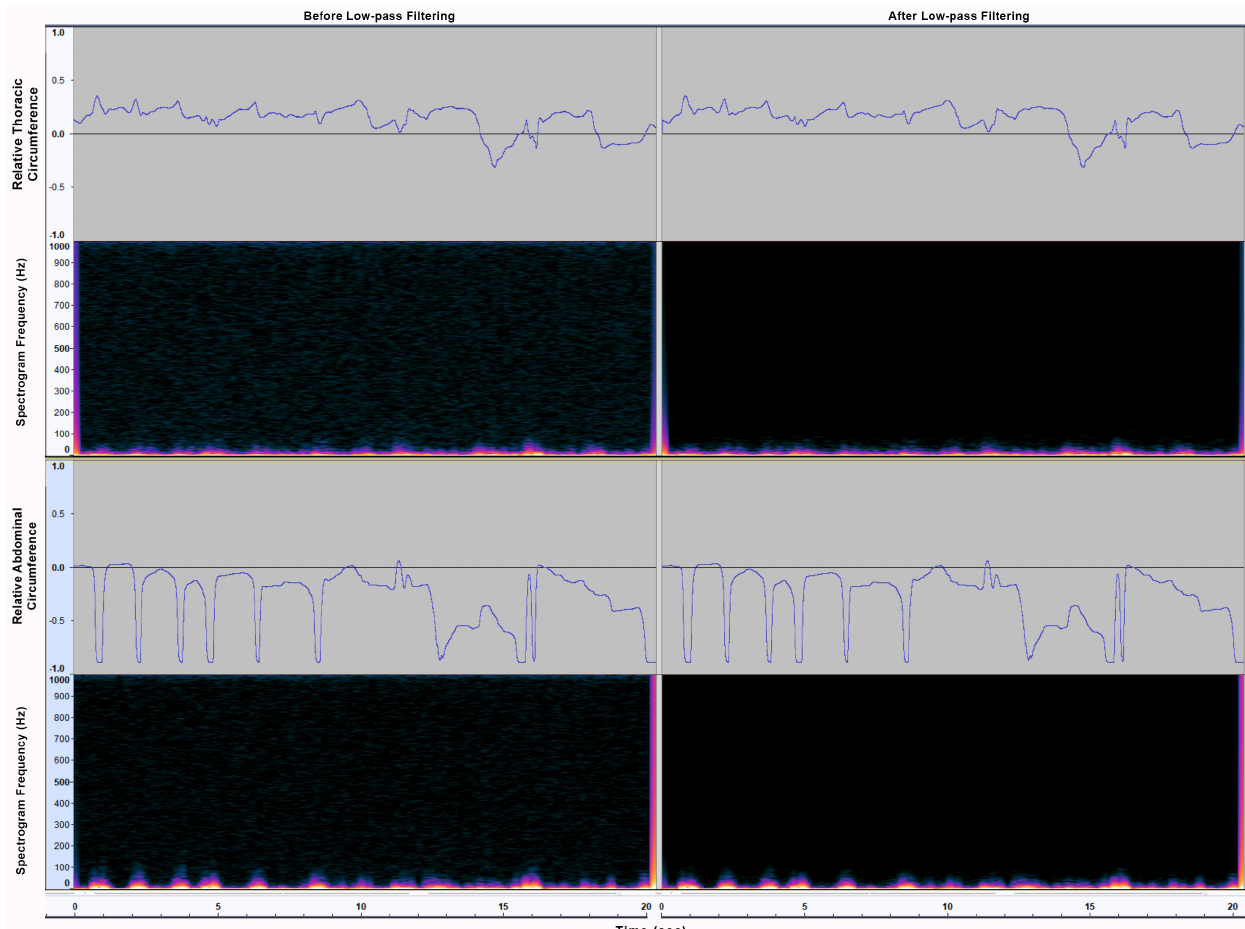
Figure 4. Waveforms and spectrograms of the two ( top and bottom ) RET sensors’ signal low-pass filter application for noise removal, in a sample of intentionally excessive muscle movement ( Left : before filtering; Right : after